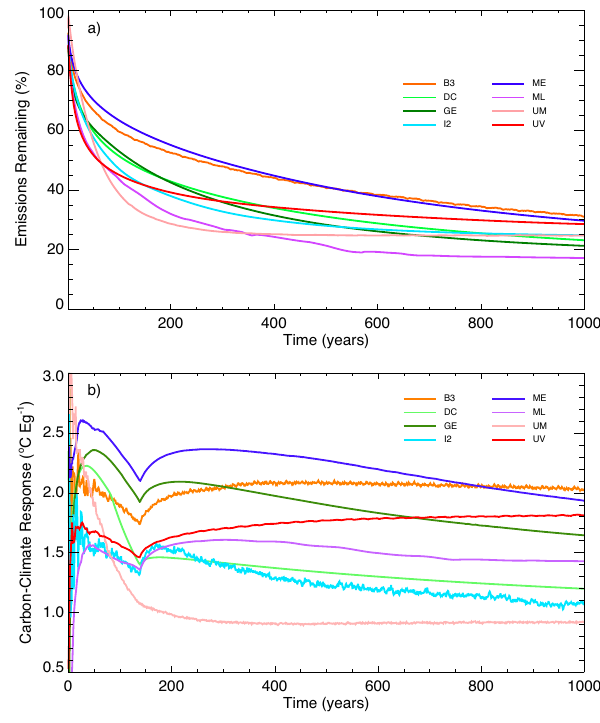
Fig. 7. Indicators of climate change longevity. The percentage of emissions remaining from a 4 × CO 2 pulse experiment is shown in (a) , and the carbon-climate response (CCR) from a 1% increase to 4 × CO 2 experiment is shown in (b) . CO 2 is allowed to freely evolve in both experiments once CO 2 has reached 4 times the initial preindustrial level. This is equivalent to about 1800Pg of carbon emissions. CCR is calculated as the change in SAT divided by the accumulated, diagnosed emissions. After year 140, emissions are zero and any changes in CCR are just due to changes in